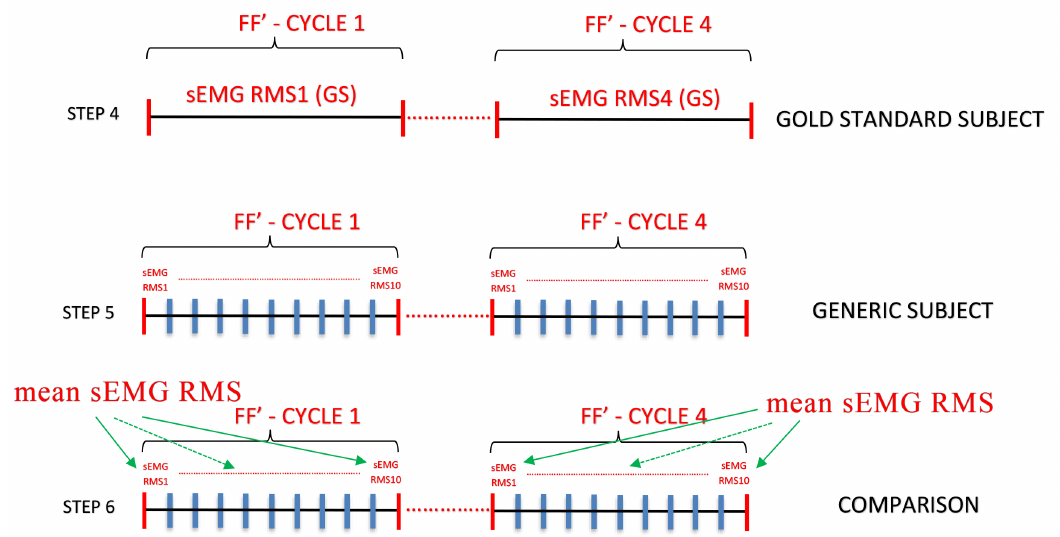
Figure 7. This is the second part of the graphic representation for the segmentation used to obtain the final decision. Only one channel is shown, but it is the same for all the other channels. Step 4 is the zoom of Step 3 referred to a gold standard subject. Step 5 is referred to a generic subject, and there is another segmentation, so there are 10 RMS sEMG values for each FF’ cycle. In Step 6 is depicted the comparison between the gold standard and the generic